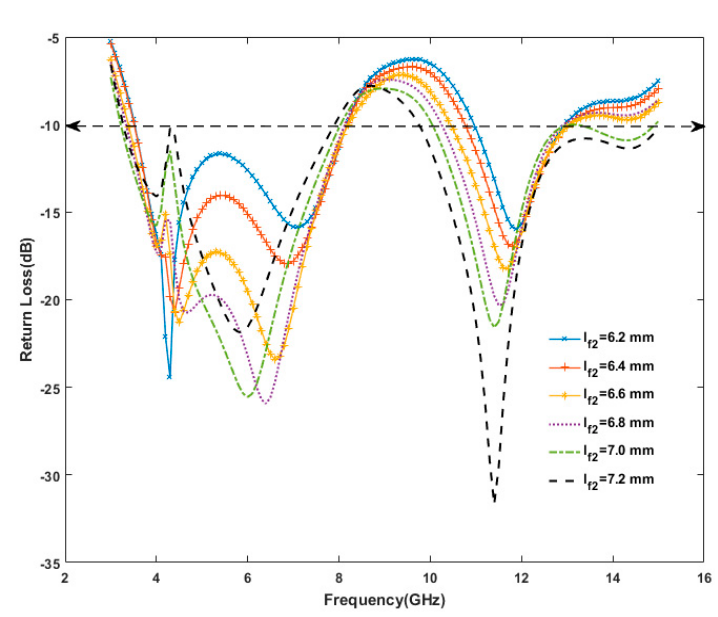
Figure 4. Study of variation on l f2 of textile antenna on the basis of return loss plot.